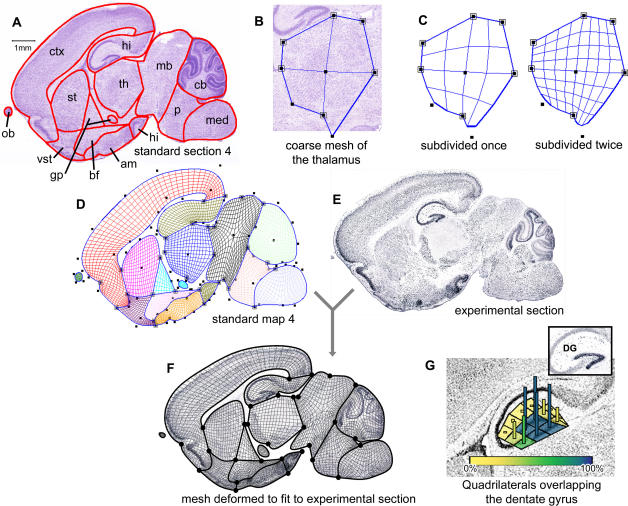
P7 Mouse Brain Atlas Construction and Application(A) Standard Nissl-stained P7 sagittal standard section number 4 with major anatomical boundaries drawn in red: amygdala (am), basal forebrain (bf), cerebellum (cb), cortex (ctx), globus pallidus (gp), hippocampus (hi), medulla (med), midbrain (mb), olfactory bulb (ob), pons (p), striatum (st), thalamus (th), and ventral striatum (vst).(B) The coarse mesh, shown here for the thalamus, is constructed by defining vertices of quadrilaterals.(C) Iterative application of subdivision generates smooth boundary curves and a smooth internal representation of smaller quadrilaterals. Fixed vertices (large squares) allow crease angles to be added to the otherwise smooth boundary curve.(D) The atlas for standard section number 4. Each coarse quadrilateral is associated with a particular anatomical structure, an association inherited during subdivision.(E) Expression pattern of Cannabinoid receptor 1 in a section similar to standard map 4.(F) The atlas (D) is deformed by moving vertices so that the anatomical boundaries match those in the Cannabinoid receptor 1 section (E).(G) Quadrilaterals overlying the DG (insert) were marked in 59 fitted maps using a mesh generated after two rounds of subdivision. In every section, the same four quadrilaterals were found to overlap the bulk of the DG.